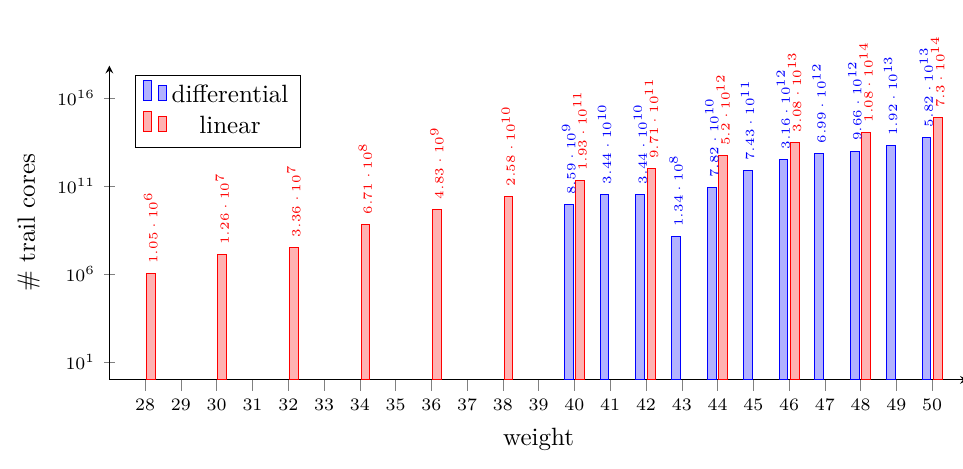
Figure 9: Number of all canonical 3-round trails per